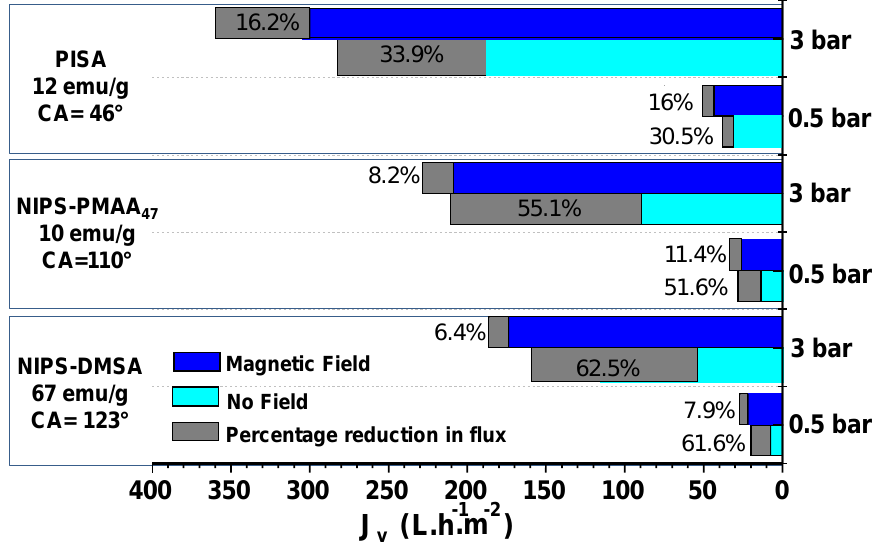
Figure 3. Graphical representation of initial and final permeate fluxes with or without the magnetic field for the membranes prepared by the Polymerization Induced Self-Assembly (PISA) and Non-solvent Induced Phase Separation (NIPS) techniques. Table 1. Ratio of permeate flux reduction, R F , in the absence and presence of magnetic field, obtained for membranes with different saturation magnetization, prepared by PISA and NIPS technologies. Saturation Magnetization Membrane The Ratio of Permeate Flux Reduction, R (emu/g) [23,24]